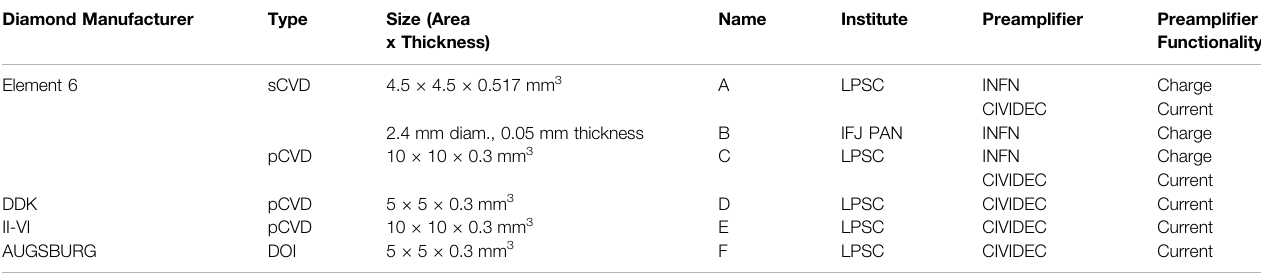
TABLE 1 | Summary of the diamond detectors and readout electronics used during the experiments at LOHENGRIN. Diamond